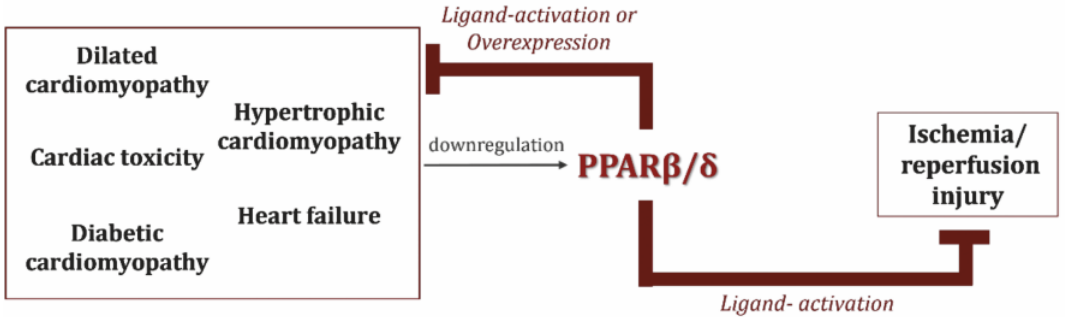
Figure 2. The role of the nuclear receptor PPAR β / δ in heart pathophysiology. Cardiac PPAR β / δ expression is impaired in several types of cardiac disease, including dilated, hypertrophic and diabetic cardiomyopathy, cardiac toxicity and heart failure. Interestingly, overexpression or pharmacological activation of PPAR β / δ has shown protective e ff ects for the diseased